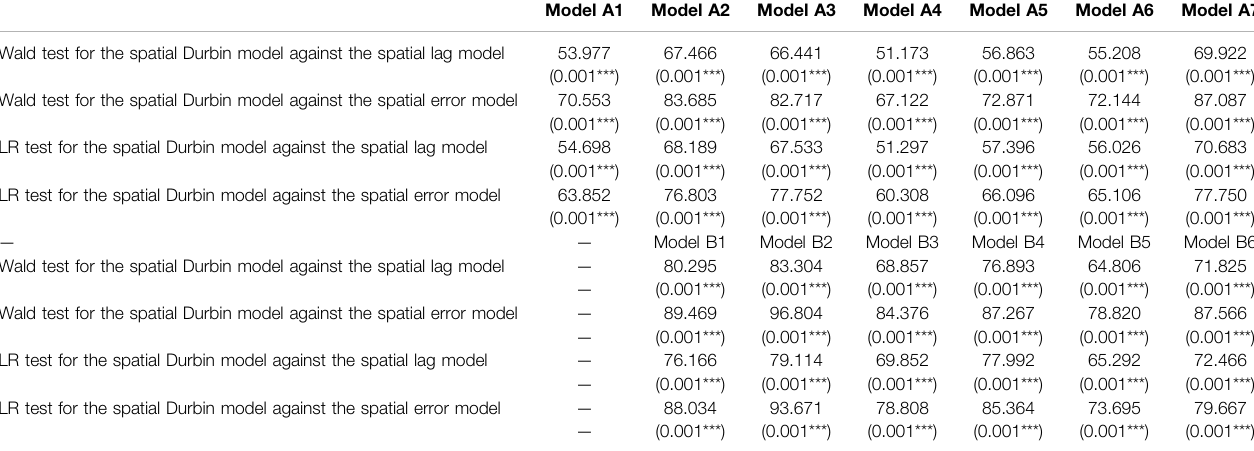
TABLE 7 | Results of the spatial Durbin